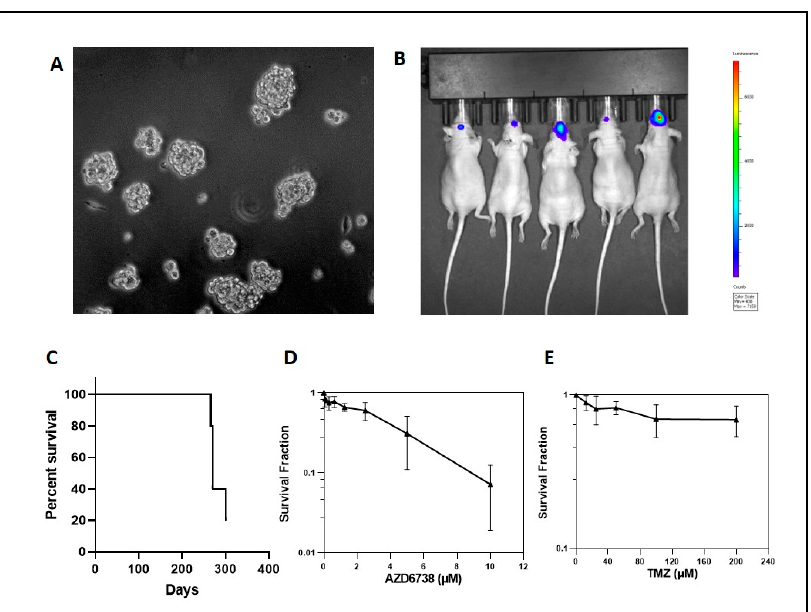
Figure 6. ATR inhibition impairs growth of the NF1-patient-derived glioblastoma cell line JHH-NF1-GBM1 in vitro: JHH-NF1-GBM1 grown under neurosphere culture conditions ( A ) and in orthotopic nude mouse xenografts ( B , C ). Decreased cell growth after treatment with the ATR inhibitor, AZD6738, was noted in vitro ( D ); although, these cells remained relatively resistant to treatment with temozolomide ( E ).